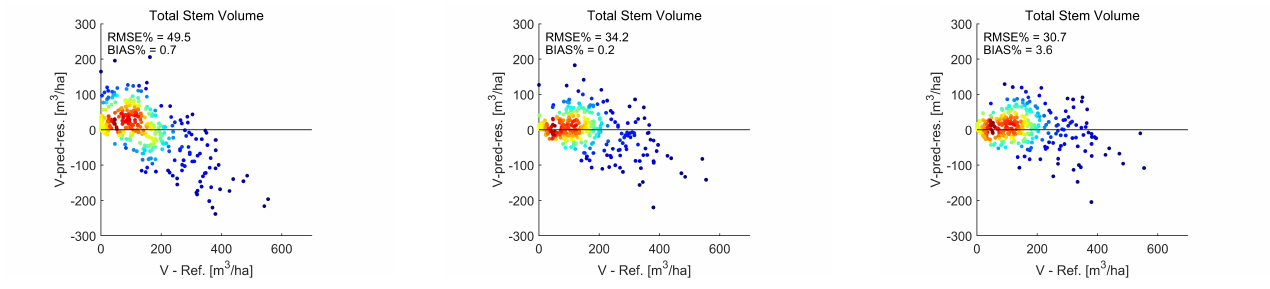
Figure 4. Residual error plots of total stem volume test set estimates for models with ( a ) 10 S2 bands (S2-10-[]), ( b ) CHM features ([E]), and ( c ) combined 10 S2 bands and CHM features (S2-10 [E]) as predictive features. In ( a ) the S2 data model the underestimates above 200 m 3 /ha and are compensated by the overestimates for lower stem volume resulting in low bias. This also applies to the model ( b ) with CHM features, although the errors are smaller. In combined data model ( c ) the underestimates above 200 m 3 /ha have been reduced significantly (thanks to CHM data), but the overestimates under this stem volume cause increased positive bias due to the data distribution.